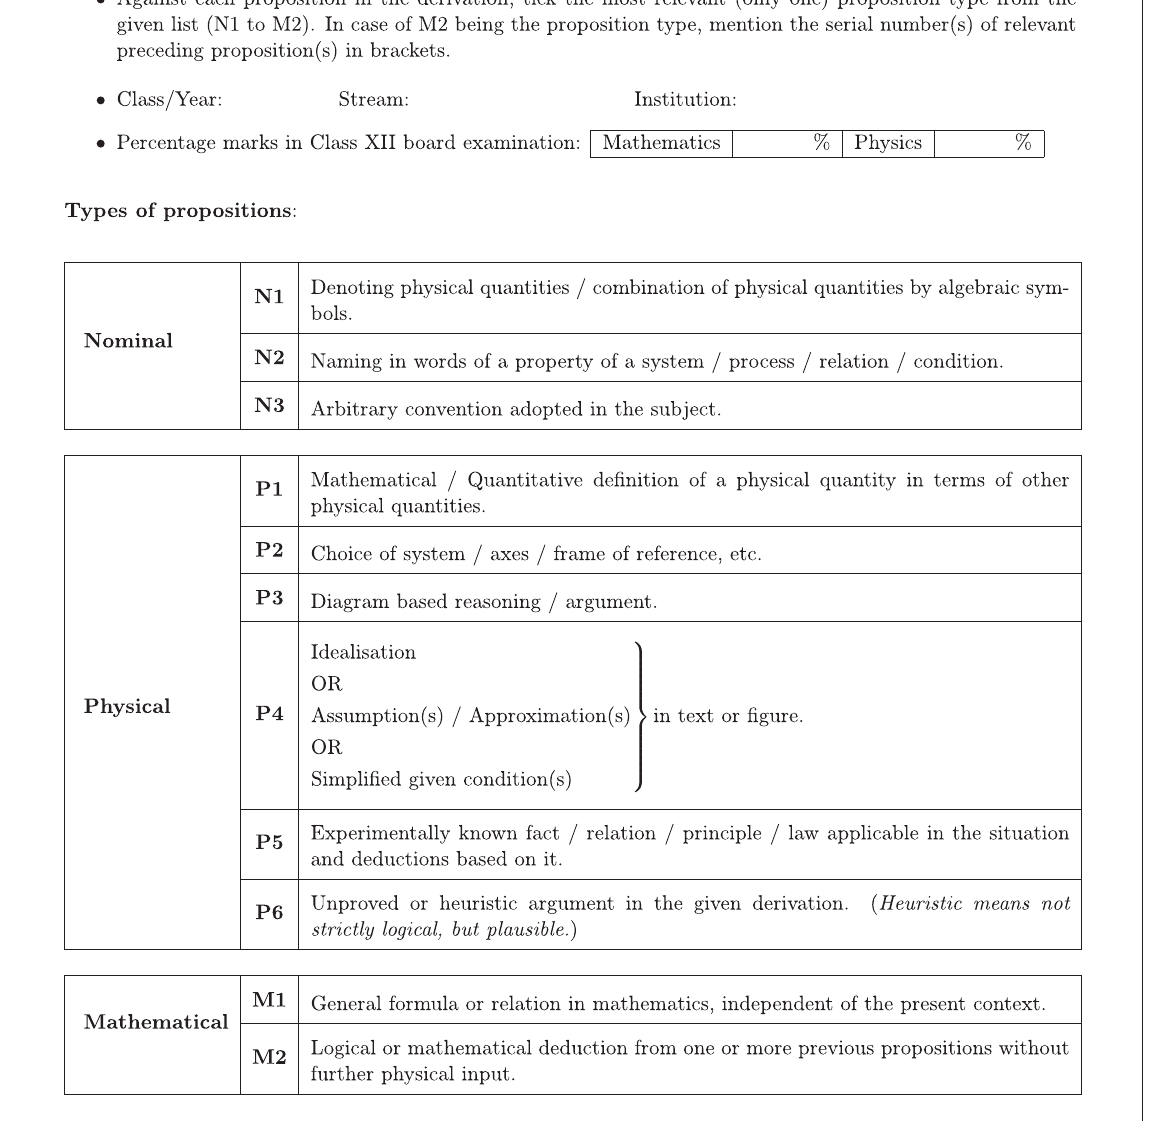
FIG. 15. Diagnostic tool for epistemic understanding: (II) Instructions for the test and types of propositions. Note: (i) The actual test contained a few additional advisory notes that are omitted here for the sake of brevity. (ii) To keep it linguistically simple for the student, the phrase “ proposition type ” was used, which we refer to as “ epistemic category ” in this paper. (iii) For ease of reference, the list of proposition types was provided at the bottom of each page of the derivation, which is suppressed here. Next parts of the tool in Figs. 16 –